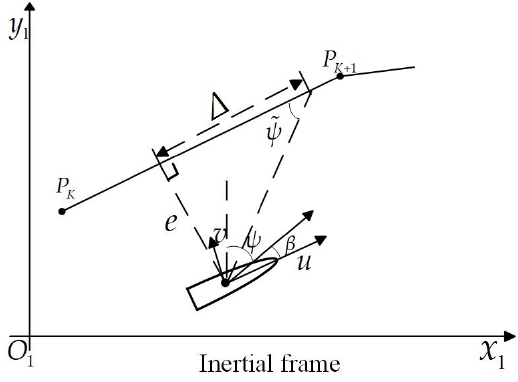
Figure 2. Geometric description of ALOS navigation algorithm.